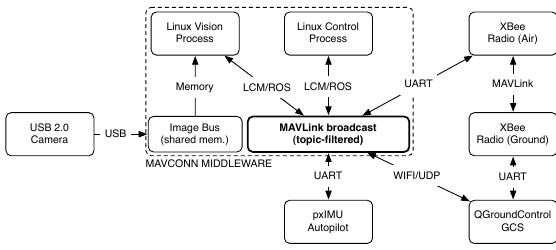
Figure 9: MAVCONN Network showing different physical links using the MAVLink protocol.